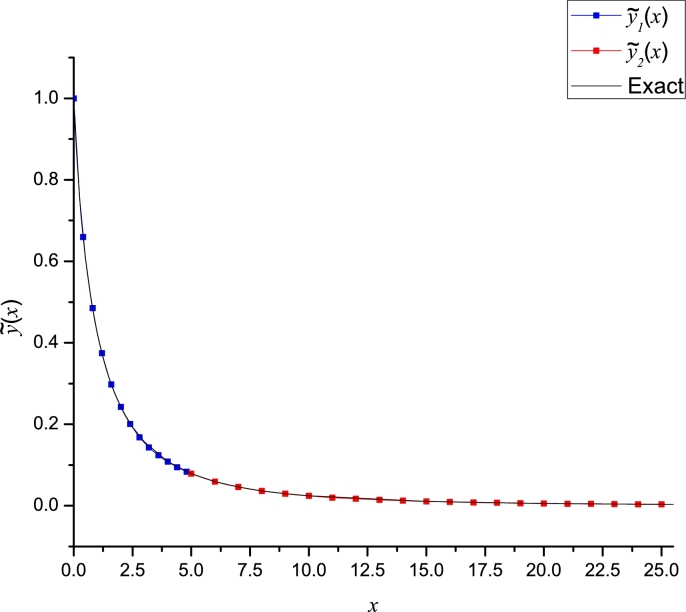
LP of TF and its numerical solution [23] (“exact”).